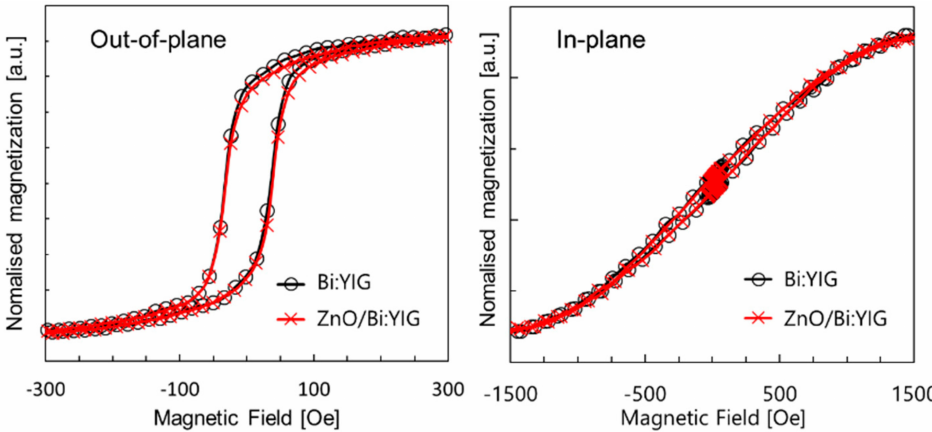
Figure 4. Comparison of the magnetization curve of single-layered Bi:YIG and Bi:YIG with